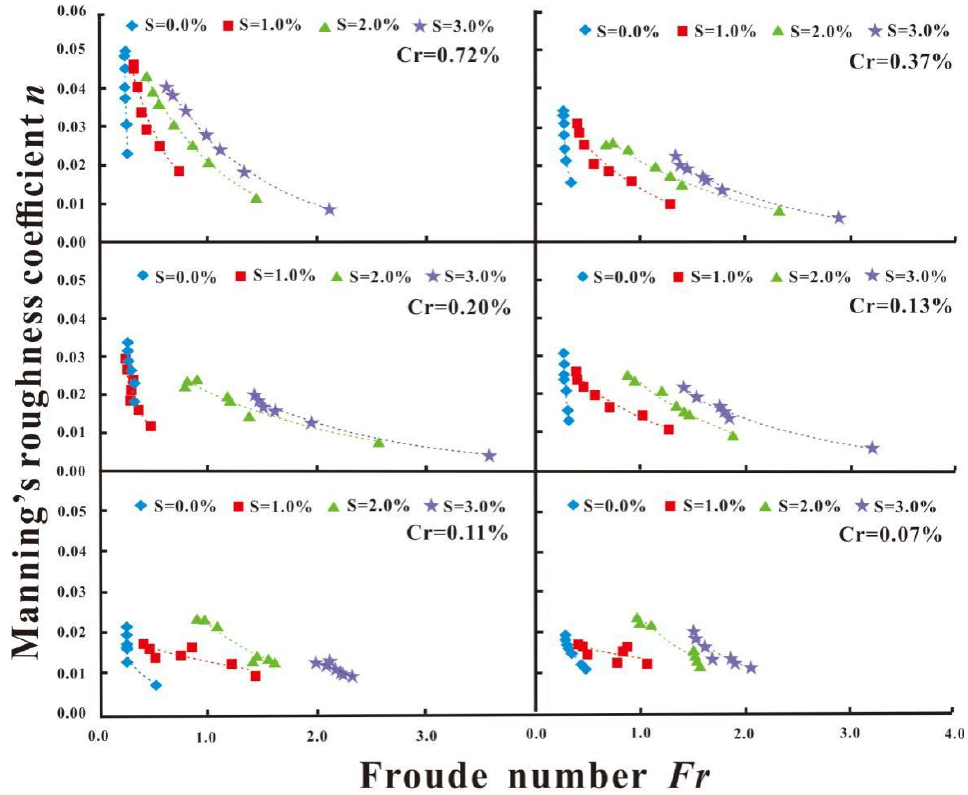
Figure 5. Manning’s roughness coefficient ( n ) for different combinations of Froude number ( Fr ), stem cover ( Cr ) and slope gradient ( S ). Stem cover range: 0.72, 0.37, 0.20, 0.13, 0.11, 0.07%; slope gradient range: 0, 1.0, 2.0, 3.0%.